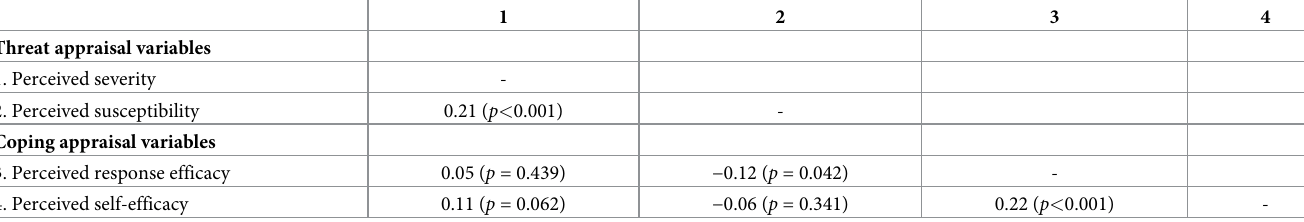
Table 2. Pearson correlation coefficients among the constructs of the protection motivation theory.